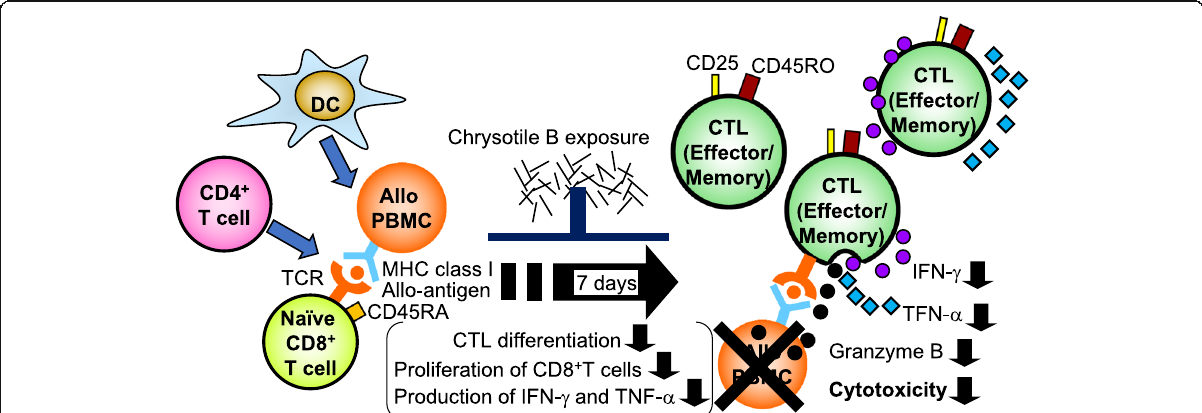
PBMCs exposed to CB, but not CR, compared with non-exposed PBMCs during the MLR. In particular, exposure to CB during the MLR suppressed the increase in granzyme B + and IFN- γ + cells. CB exposure also suppressed the increase in CD45RO + effector/memory and CD25 + -activated cells in CD8 + lymphocytes, and the decrease in CD45RA + cells. Moreover, the production of IFN- γ and TNF- α decreased in the presence of CB